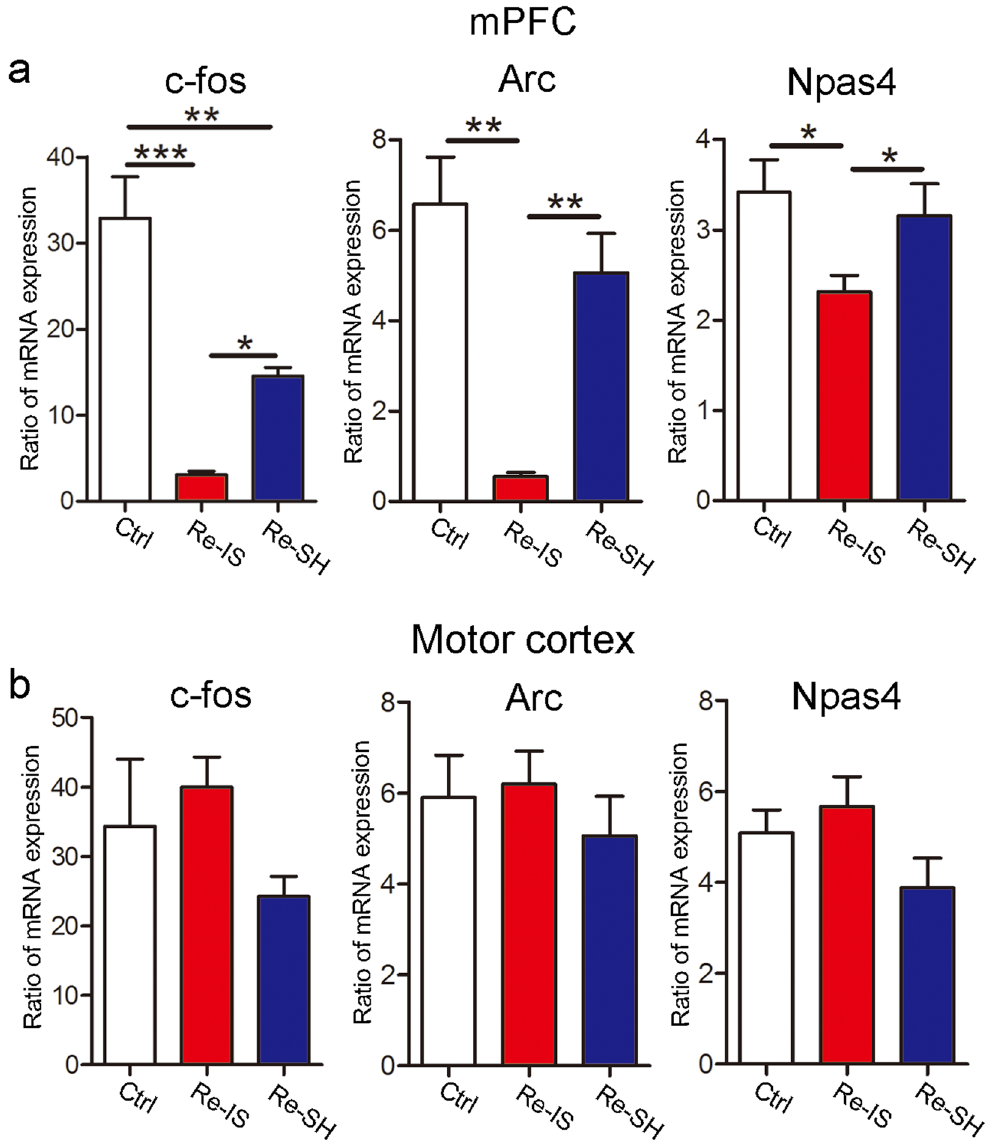
Figure 2. Immediate early gene responses in the medial prefrontal cortex (mPFC) depend on the mode of re-socialization. ( a , b ) Ratio of immediate early gene (IEG) expression 30 min after exposure to a strange mouse (IEG mRNA expression with exposure/IEG mRNA expression without exposure) in the mPFC and motor cortex. ( a ) While an increase in cFos expression caused by exposure to a strange mouse was significantly decreased in both Re-IS and Re-SH mice, as compared to Ctrl mice, Re-SH mice showed a higher cFos response than Re-IS mice. The response of Arc and Npas4 in Re-IS mice was lower than that of Ctrl and Re-SH mice, and Ctrl and Re-SH mice showed a comparable response. ( b ) In the motor cortex, there were no differences in terms of changes in IEG expression after exposure to a strange mouse. n = 4/group, * p < 0.05, ** p < 0.01, *** p < 0.001. Error bars =